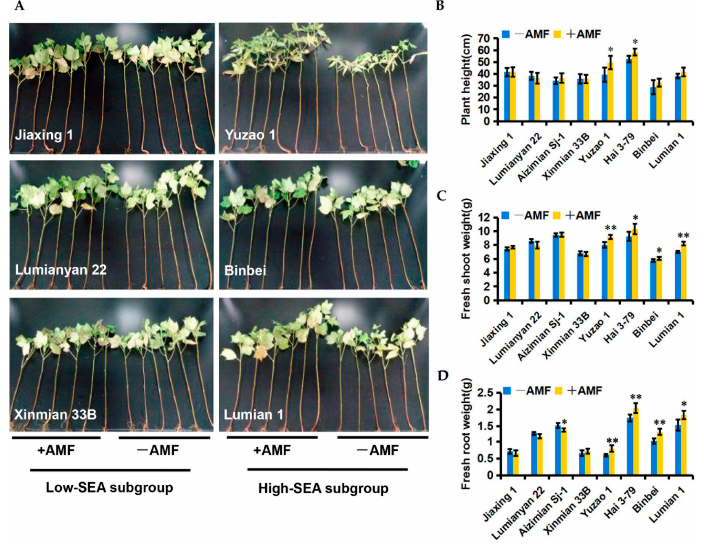
Figure 2. Effects of different symbiotic efficiency of AMF (SEA) on cotton growth promotion at 60 days post inoculation (dpi) under greenhouse conditions. +AMF: mycorrhizal; − AMF: nonmycorrhizal. ( A ) The growth phenotypes of two cotton subgroups. The low-SEA subgroup (SEA ≤ 26%) was comprised of Jiaxing 1, Lumianyan 22, Aizimian Sj-1, and Xinmian 33B. The high-SEA